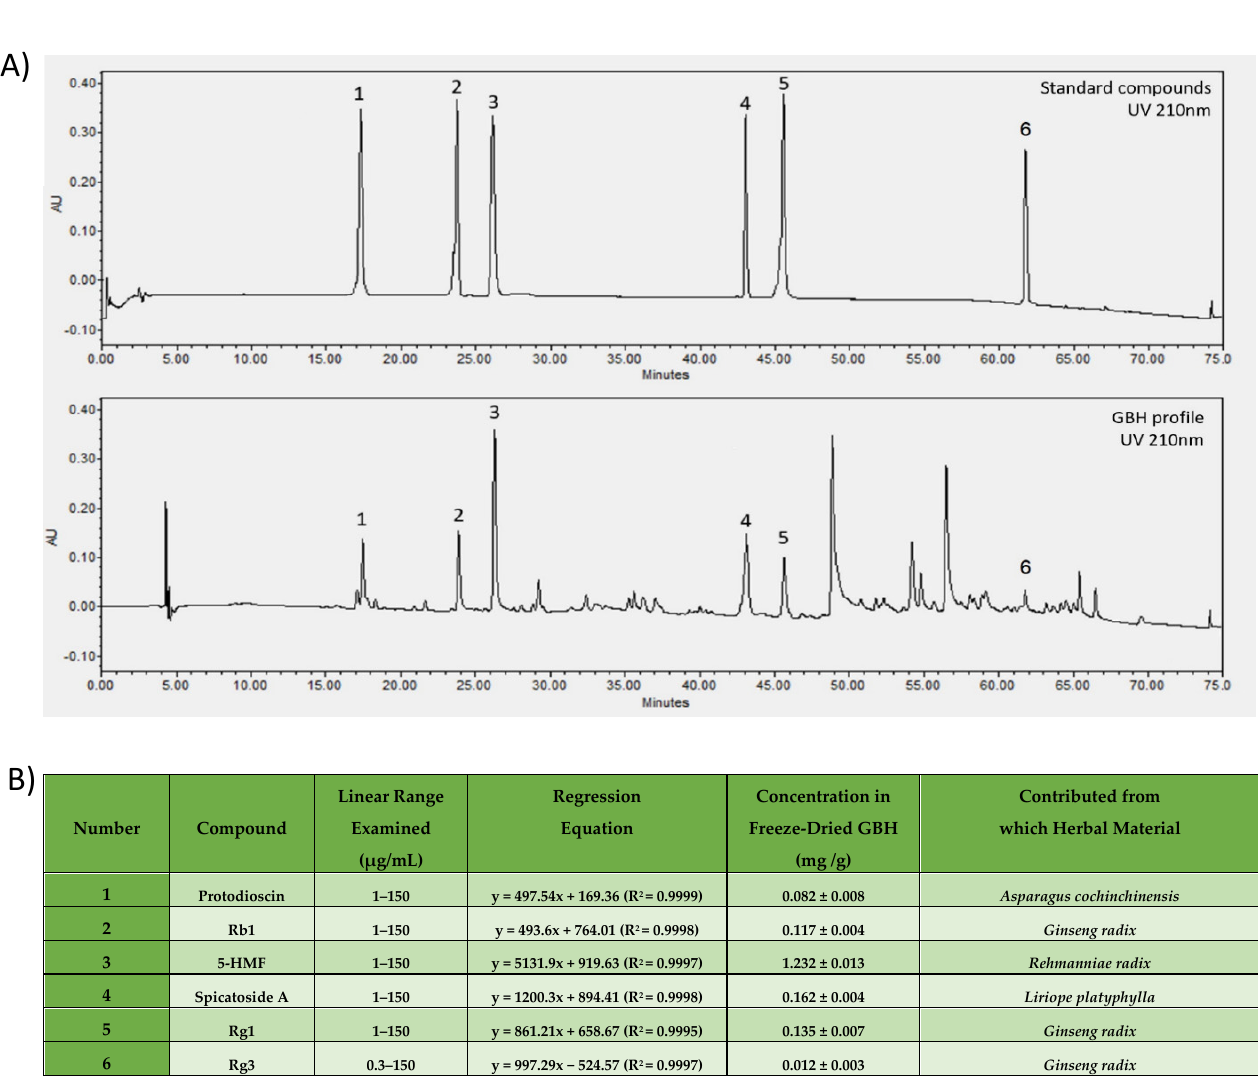
Figure 2. HPLC analysis of GBH. Confirmation of key standard compounds ( A ) Chromatogram of standard compounds and GBH profile. ( B ) Detailed analysis data with references of previous studies that identified the standard compounds in the respective herbal materials, all identified compounds in GBH sample had presented concentrations within the examined linear range 1–150 μ g/mL.